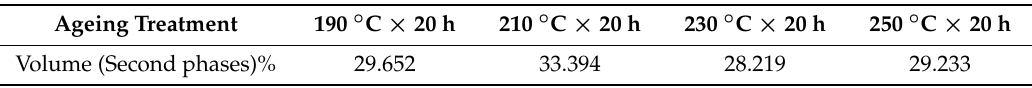
Table 3. ImageJ software statistical results for alloy subjected to different ageing treatments as shown in Figure 9.